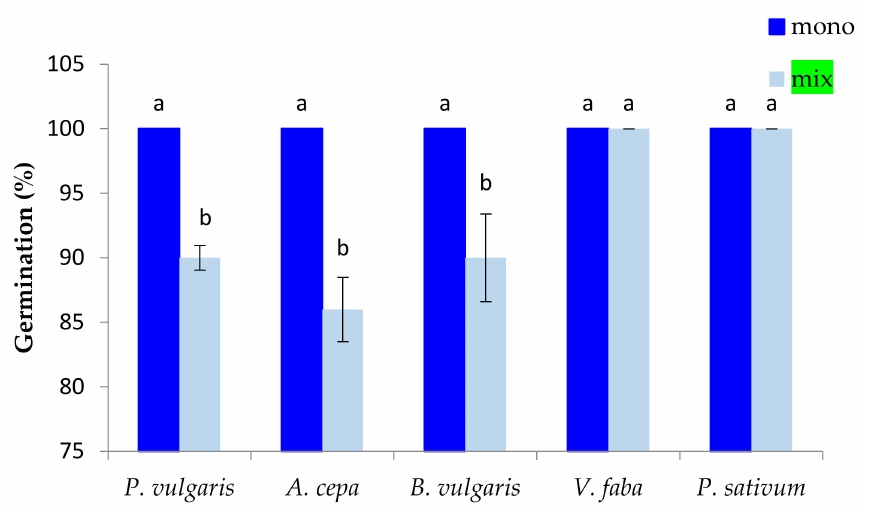
Figure 6. Percent germination of P. oleracea grown with crop seeds (mono = weed alone; mix = weed grown together with crop). Bars represent the means of 4 replicates ± SE. Bars topped by the same letter indicate no significant difference between treatments at the 5% level using Duncan’s multiple-range test.